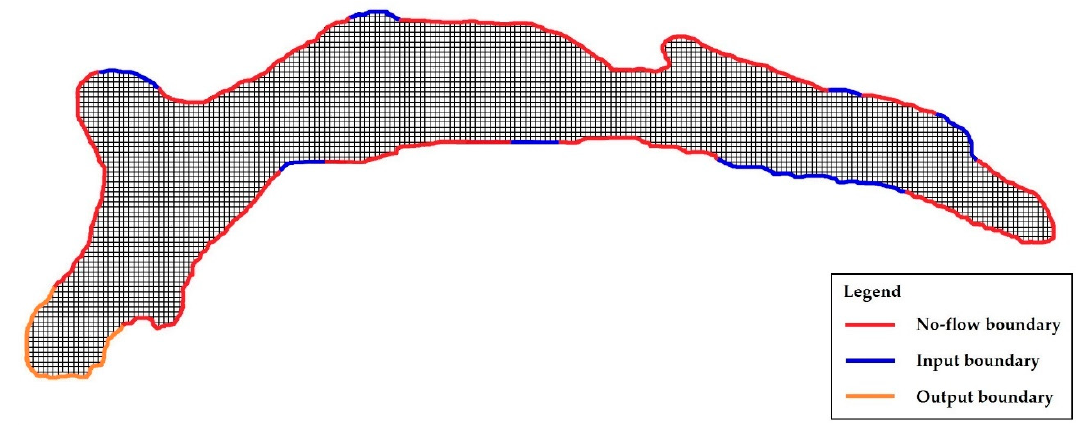
Figure 13. Boundary conditions of the model.